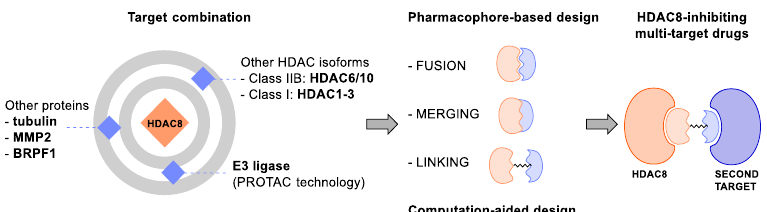
Figure 9. Schematic representation of the biological targets recruited by the reported polyphar- macological tools alongside HDAC8, the suitable approaches to their design and their mode of ac-